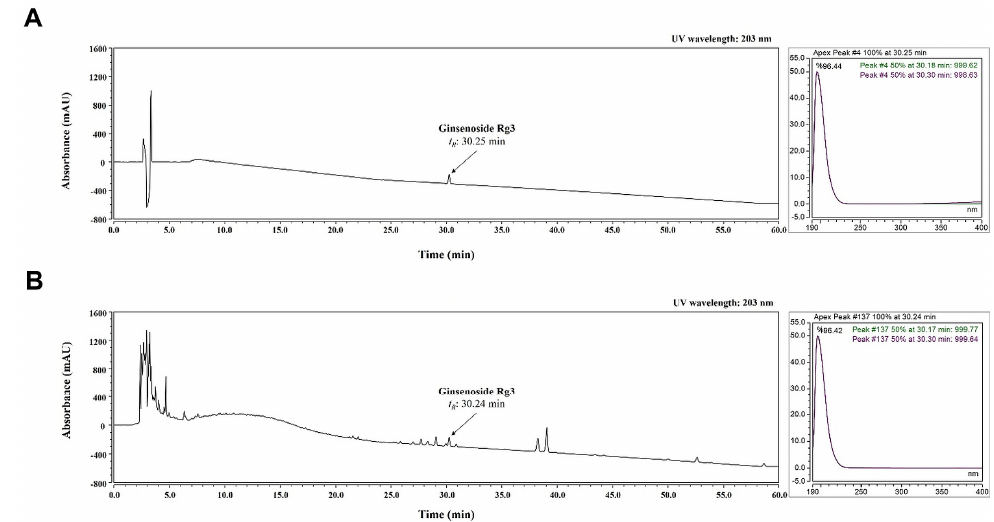
Figure 5. HPLC analysis of ginsenoside Rg3 in RGE at UV wavelengths of 203 nm. UV chromatograms of standards of ginsenoside Rg3 ( A ) and ginsenoside Rg3 in RGE ( B ).